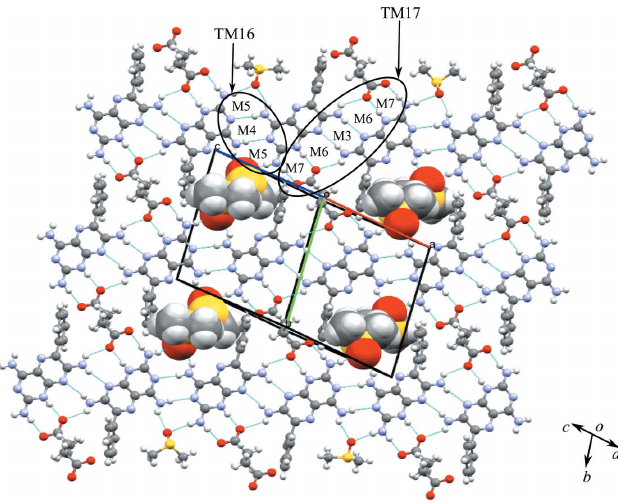
Figure 8 Motifs M5, M4 and M5 (TM16), and M7, M6, M3, M6 and M7 (TM17) found in the hydrogen-bonded sheets of 1c (cid:3)